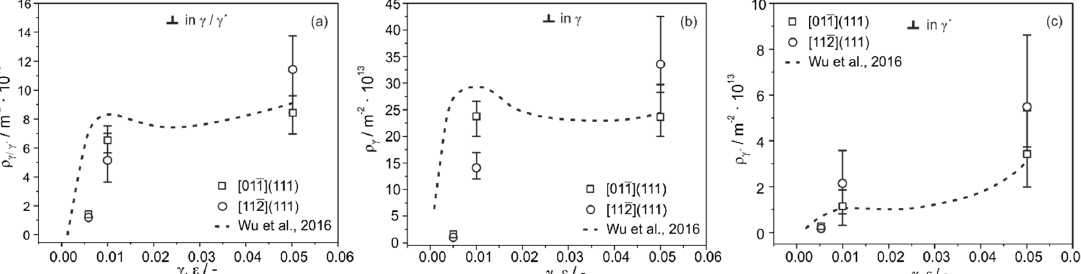
Figure 8. Evolution of dislocation densities during [ 011 ]( 111 ) and [ 112 ]( 111 ) shear creep testing at 750 ◦ C and 300 MPa (dislocation densities vs. shear strain γ ). Dislocation densities from [001] tensile creep tests reported by Wu et al. [10] (dislocation densities vs. tensile strain ε ). ( a ) Overall dislocation density. ( b ) γ -channel dislocation density. ( c ) Dislocation density in the γ ʼ -phase.